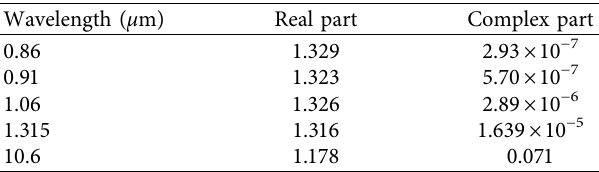
Table 1: Te refractive index of fog droplet related to the wave- length of the incident